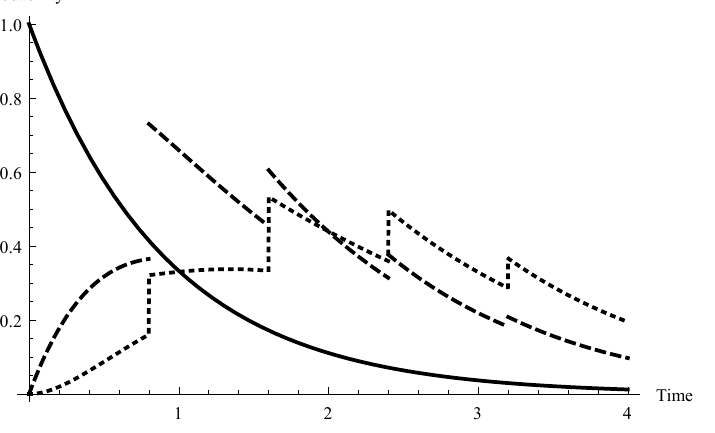
Figure 1. Transient probabilities P { X ( t ) = m , t ∈ I 1 } for λ = 1.1 and for m =